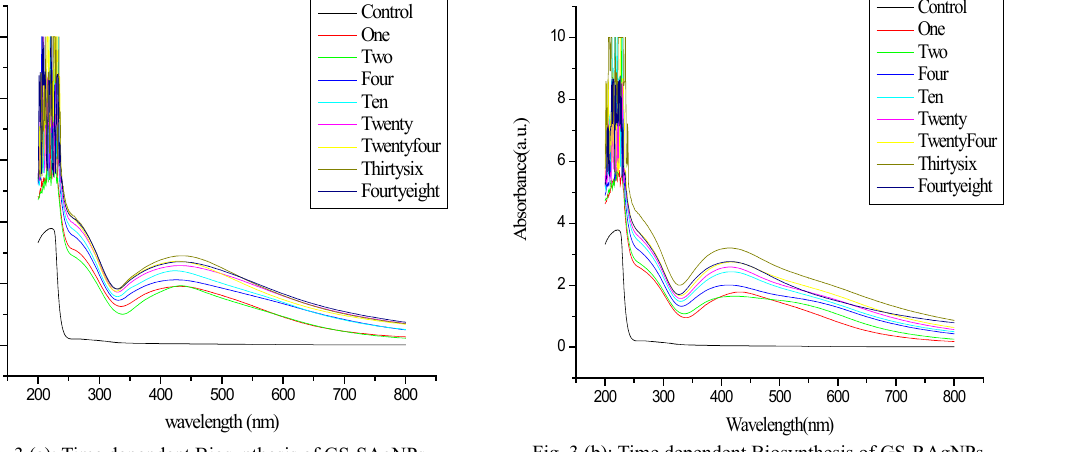
Fig. 3 (b): Time dependent Biosynthesis of GS-RAgNPs